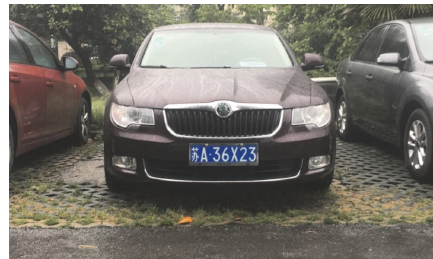
Figure 1: Original image of a